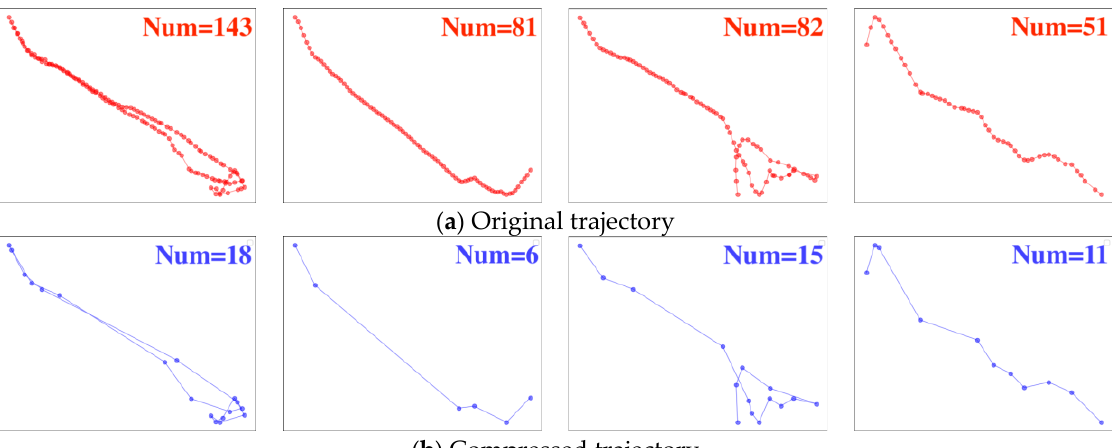
Figure 4. Trajectory point compression effect.